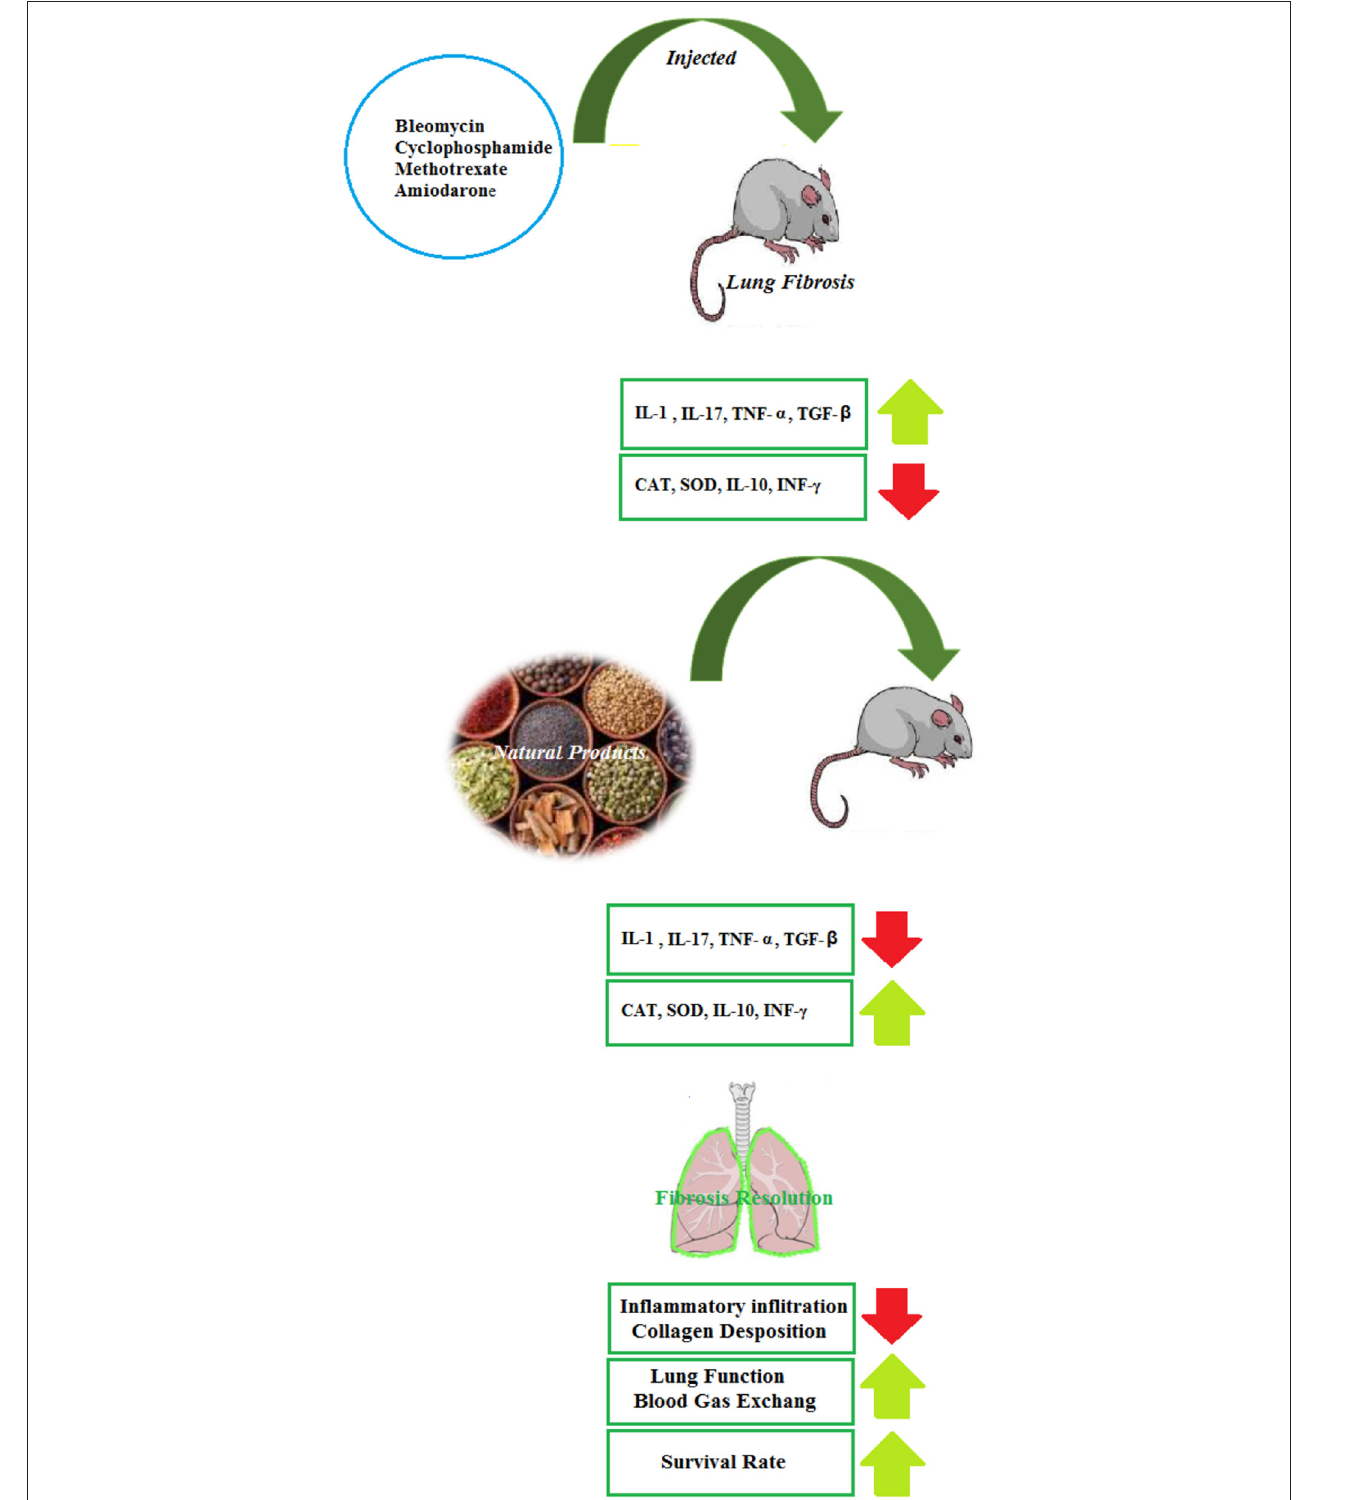
FIGURE 2 | Inhibitory effects of NP on pulmonary fibrosis induced by various noxious agents.